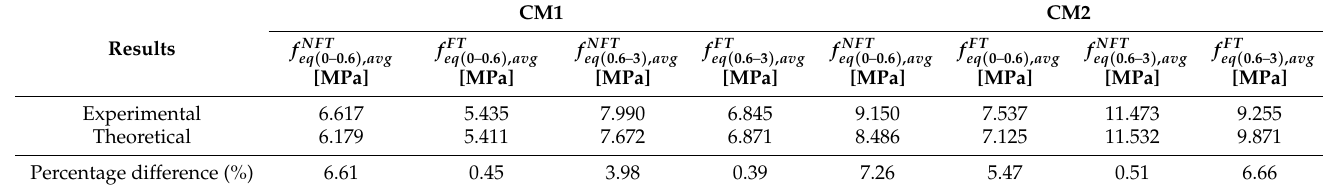
Table 5. Comparison between the experimental and theoretical average values of the two equivalent postcracking strengths after the freeze – thaw cycles, 𝑓 𝑒𝑞(0–0.6),𝑎𝑣𝑔𝐹𝑇 and 𝑓 𝑒𝑞(0.6–3),𝑎𝑣𝑔𝐹𝑇 , and those before the freeze – thaw cycles of Ref. [42], 𝑓 𝑒𝑞(0–0.6),𝑎𝑣𝑔𝑁𝐹𝑇 and 𝑓 𝑒𝑞(0.6–3),𝑎𝑣𝑔𝑁𝐹𝑇 , for the CM1 and CM2 mixtures.